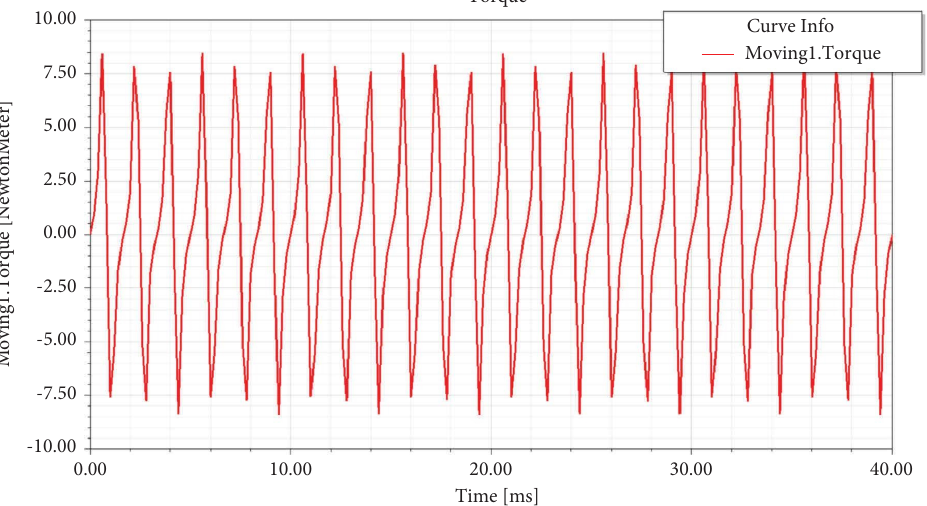
Figure 14: Magnetic resistance torque curve of 6-pole 24-slot motor.